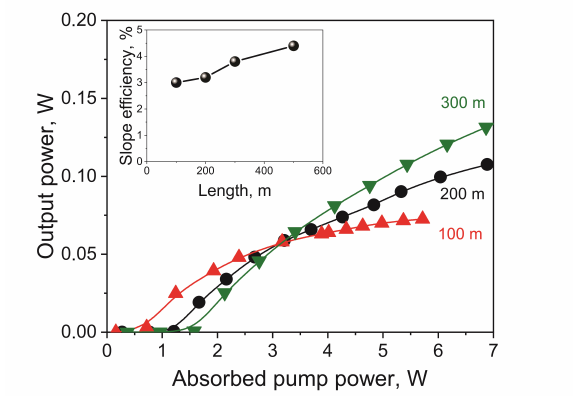
Figure 5. Total output power of BDFLs operating in free-running regime as a function of the absorbed pump power. Inset: slope efficiency of the BDFLs for low pump powers versus active fiber